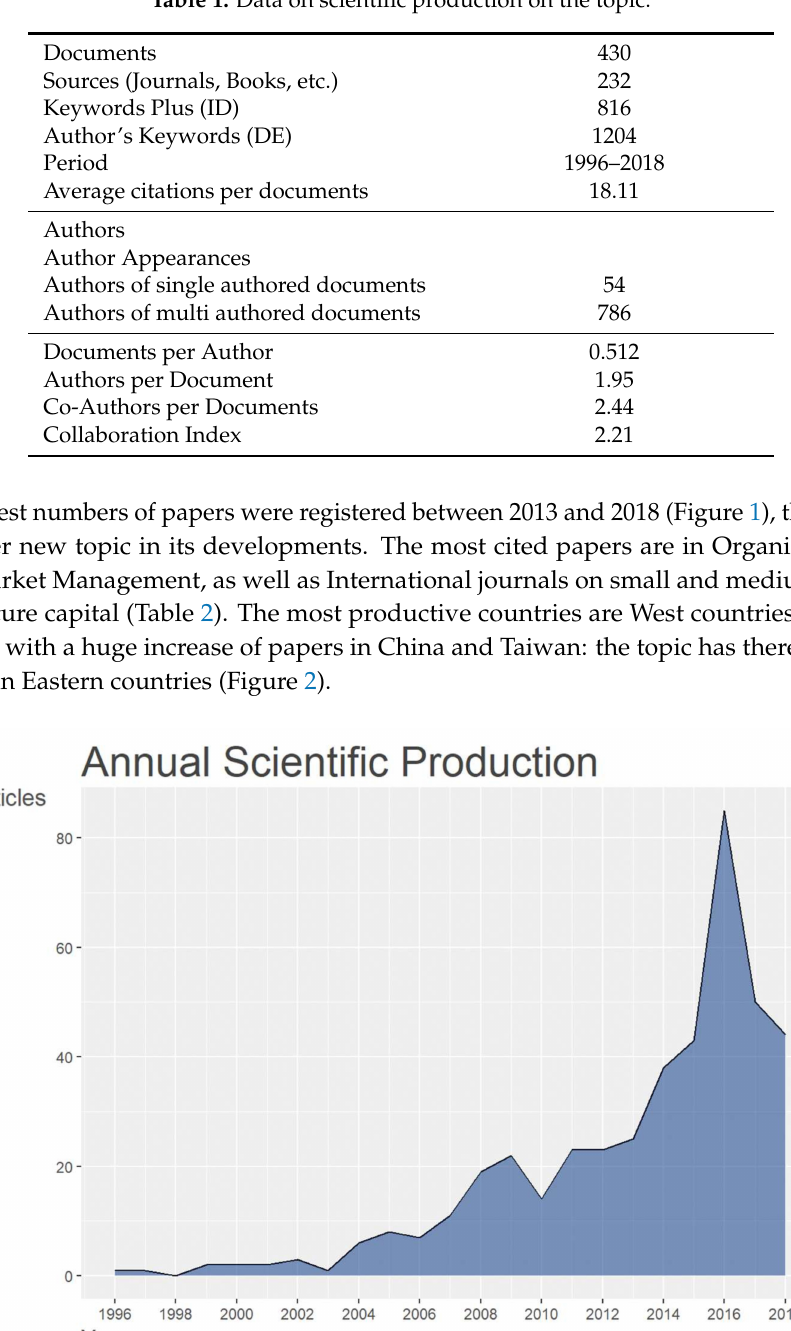
Table 1. Data on scientific production on the topic.